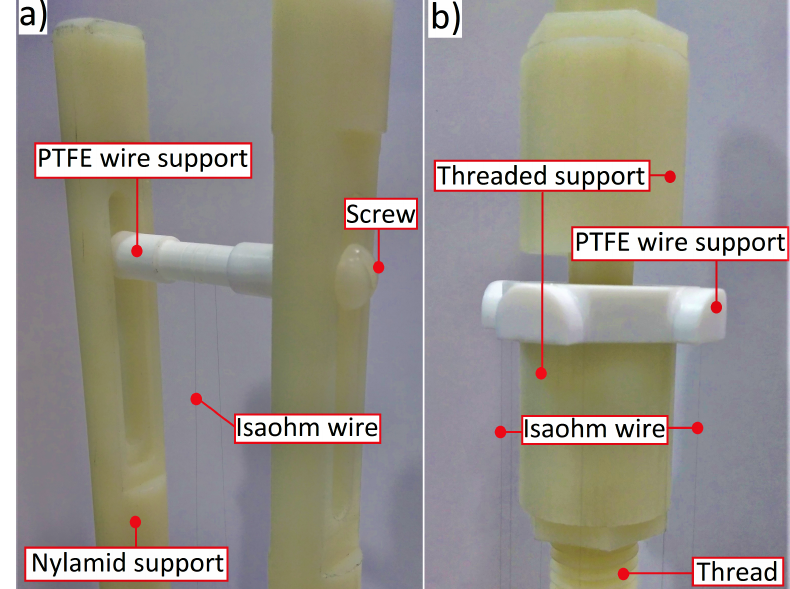
Figure 4. CR’s wire supports with strain adjustment system, for: ( a ) the bifilar CR, and ( b ) the octofilars